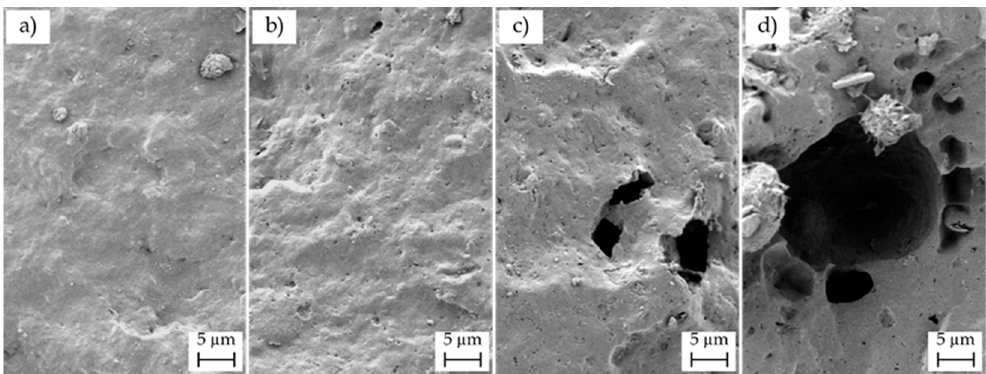
Figure 9. Field-emission scanning electron microscopy (FESEM) images of the fracture surfaces of the injection-molded poly(3-hydroxybutyrate- co -3-hydroxyhexanoate) [P(3HB- co -3HHx)]/hydroxyapatite nanoparticles (nHA) parts after selective attack with 6M hydrochloric acid (HCl) for 12 h: ( a ) P(3HB- co -3HHx) + 2.5 nHA; ( b ) P(3HB- co -3HHx) + 5 nHA; ( c ) P(3HB- co -3HHx) + 10 nHA; ( d ) P(3HB- co -3HHx) + 20 nHA. Images were taken at 1000× with scale marker of 5 µm.